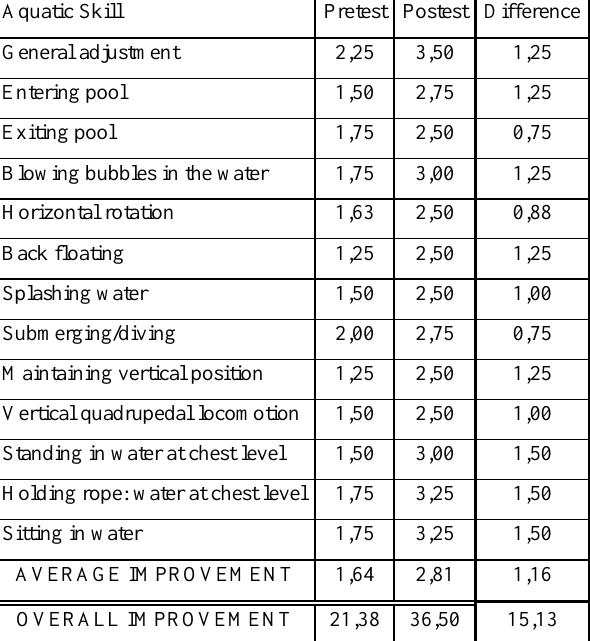
Table 3 Results for Students with